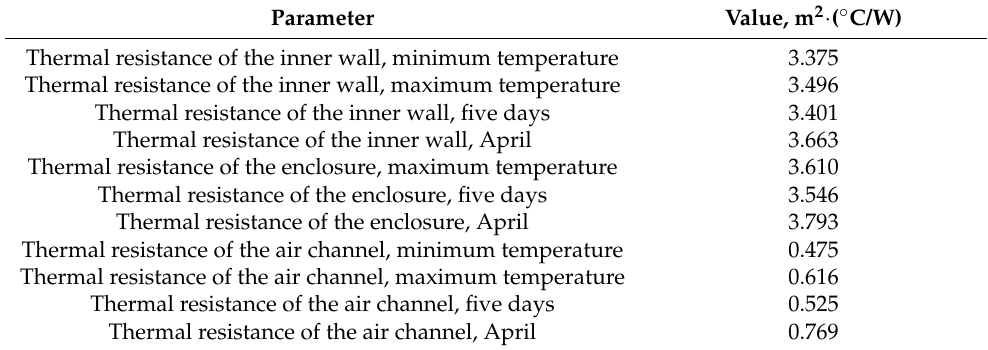
Table 10. Thermal resistance of the enclosure according to Figure